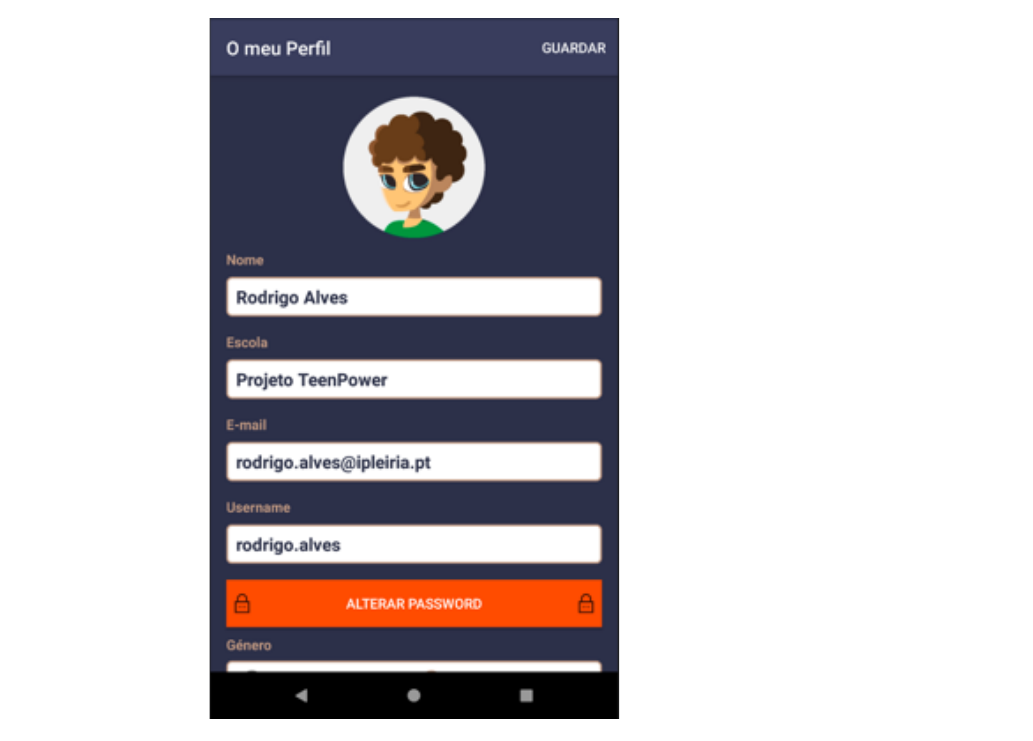
Figure 4. Profile —basic information such as name (“nome”) and school (“escola”)— storytelling.